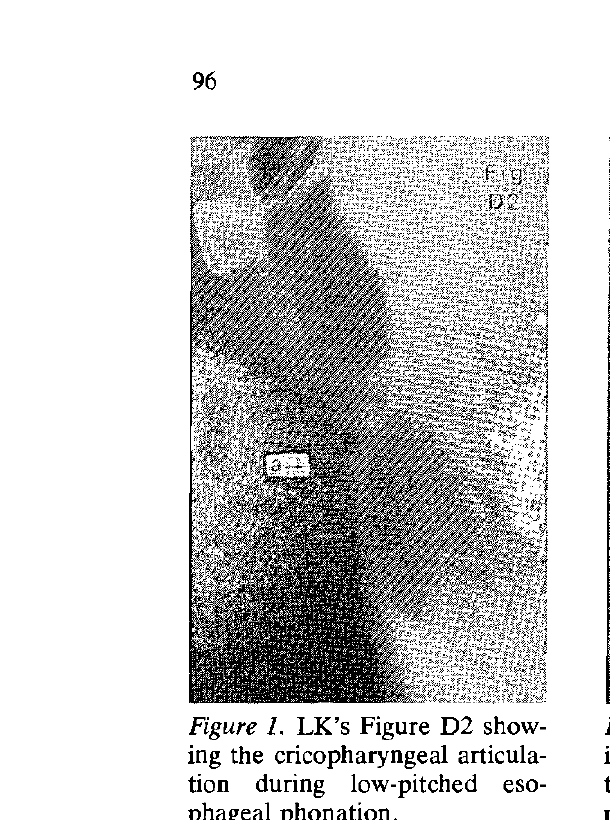
Figure 1. LK's Figure D2 show- ing the cricopharyngeal articula- tion during low-pitched eso- phageal phonation.